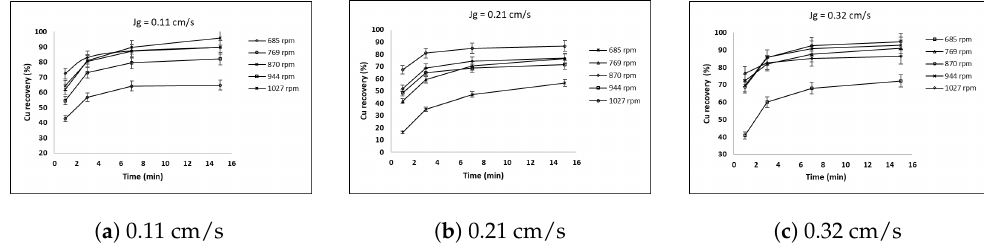
Figure 12. Copper recovery vs. time at different J g values ( a ) 0.11 cm/s, ( b ) 0.21 cm/s and ( c ) 0.32 cm/s) using the 7 cm diameter